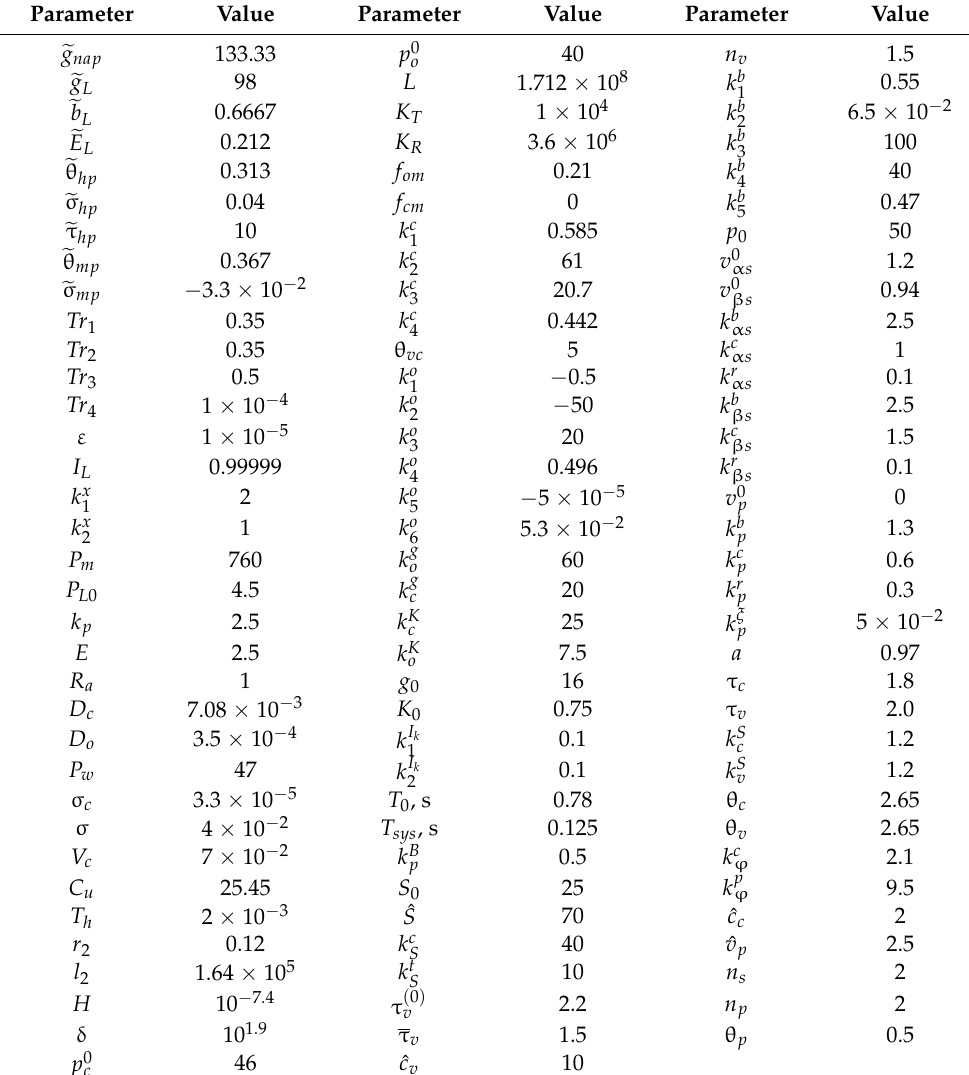
Table 1. Parameters of the